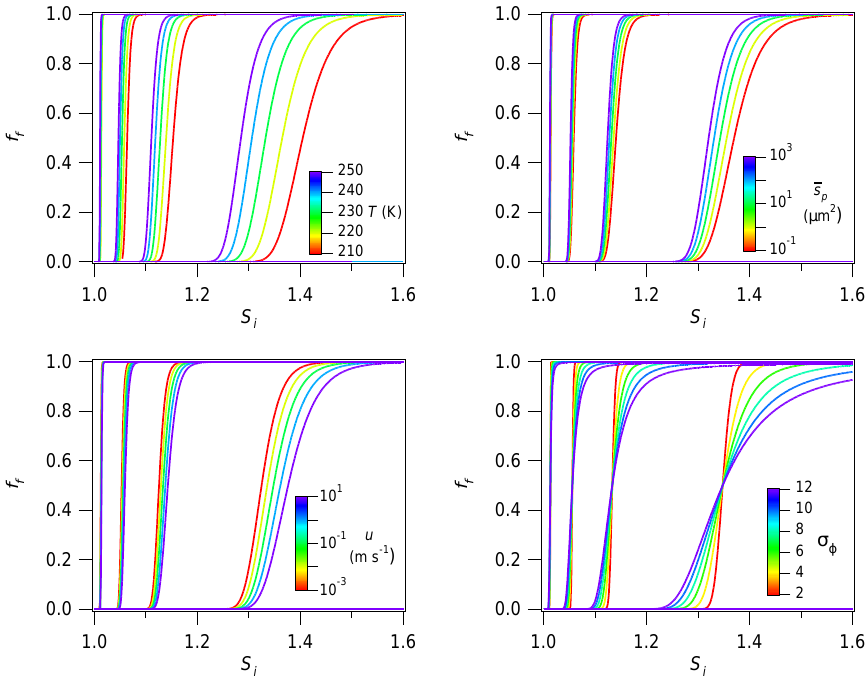
Fig. 3. Heterogeneous ice nucleation spectra in the deposition mode. Lines are grouped by characteristic contact angle, ¯ θ = [ 5 ◦ , 10 ◦ , 15 ◦ , 23 ◦ ] (from left to right). Unless otherwise specified u = 0 . 1ms − 1 , ¯ s p = 5 µm 2 , σ ϕ = 5, and T = 225K. values of ϕ < 0 are not accessible to N ( ¯ ϕ) . Thus, the